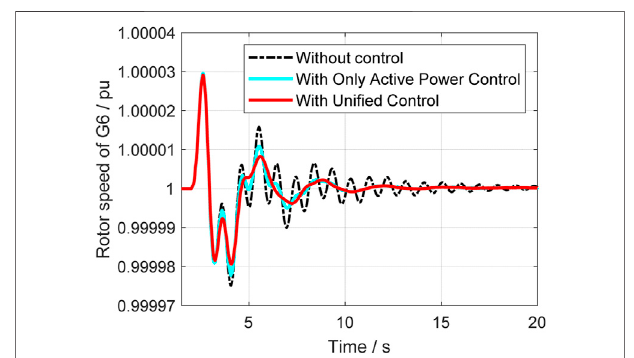
FIGURE 18 | Reactive power of VSC with different